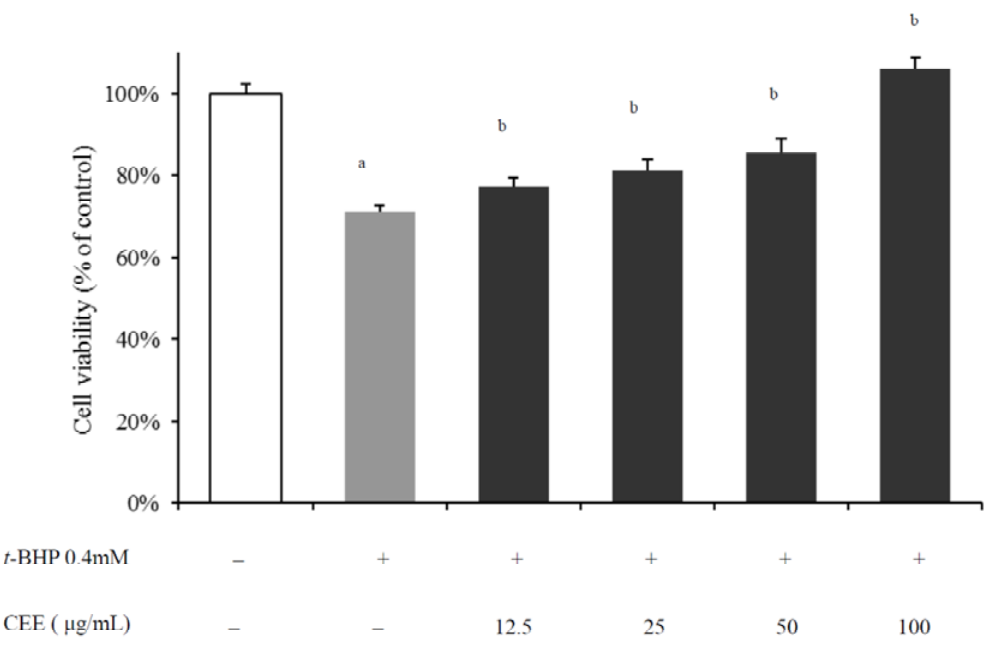
Figure 1. Effect of CEE on cytotoxicity of t -BHP-induced HepG2 cells (N = 6). HepG2 cells were treated with CEE (12.5, 25, 50 or 200  g/mL) in the presence of t -BHP (0.4 mM) for 3 h, and cell viability was determined by MTT assay. a p < 0.01, compared with control; b p < 0.01, compared with t -BHP-treated cells. CEE: Cichorium endivia L. extract; t -BHP: tert -butyl